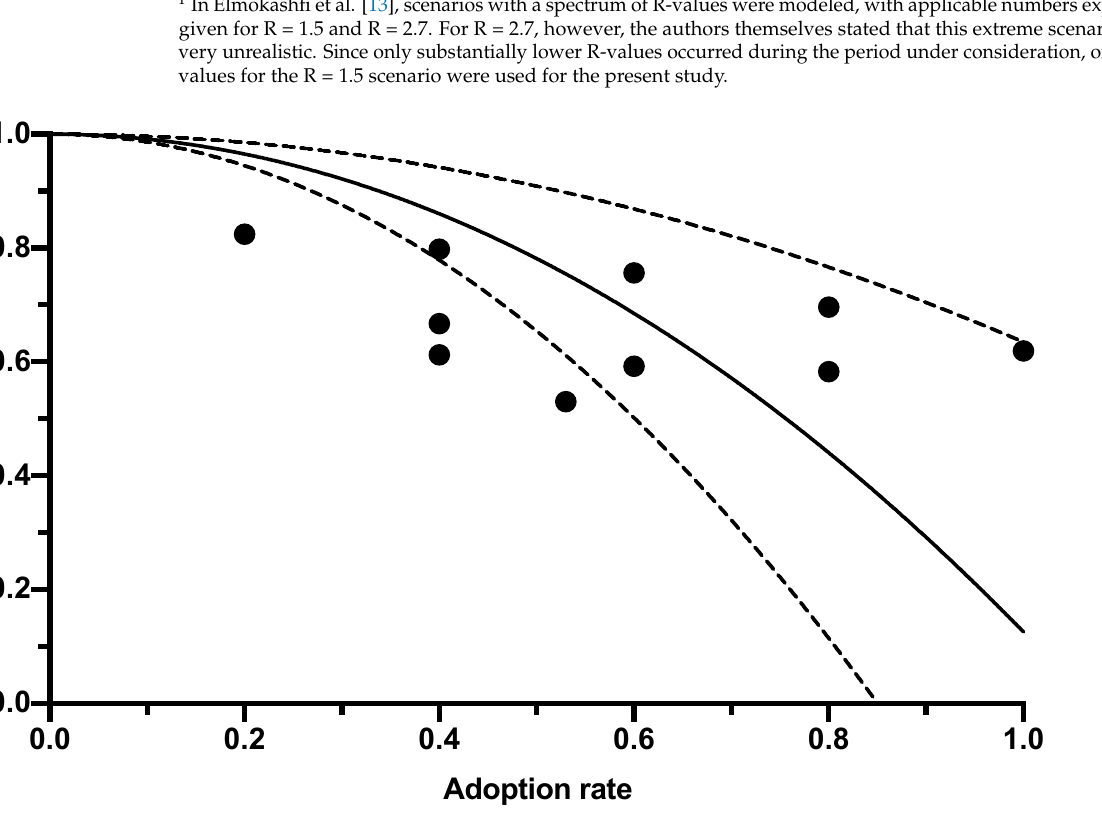
Figure 1. Relationship between the reduction in the R-value and the adoption rate of digital contact tracing apps. The black dots mark the results of the individual studies reported in Table 1. The solid line corresponds to the regression curve (y = 1 − β 2 × 0.8741). The dashed lines mark the 95% CI. To infer how the reduction of R eff by the CWA affects the number of cases, the cor- relation of R eff with the percentage rate of new infections in relation to the sum of new infections of the past 16 days was calculated (Figure